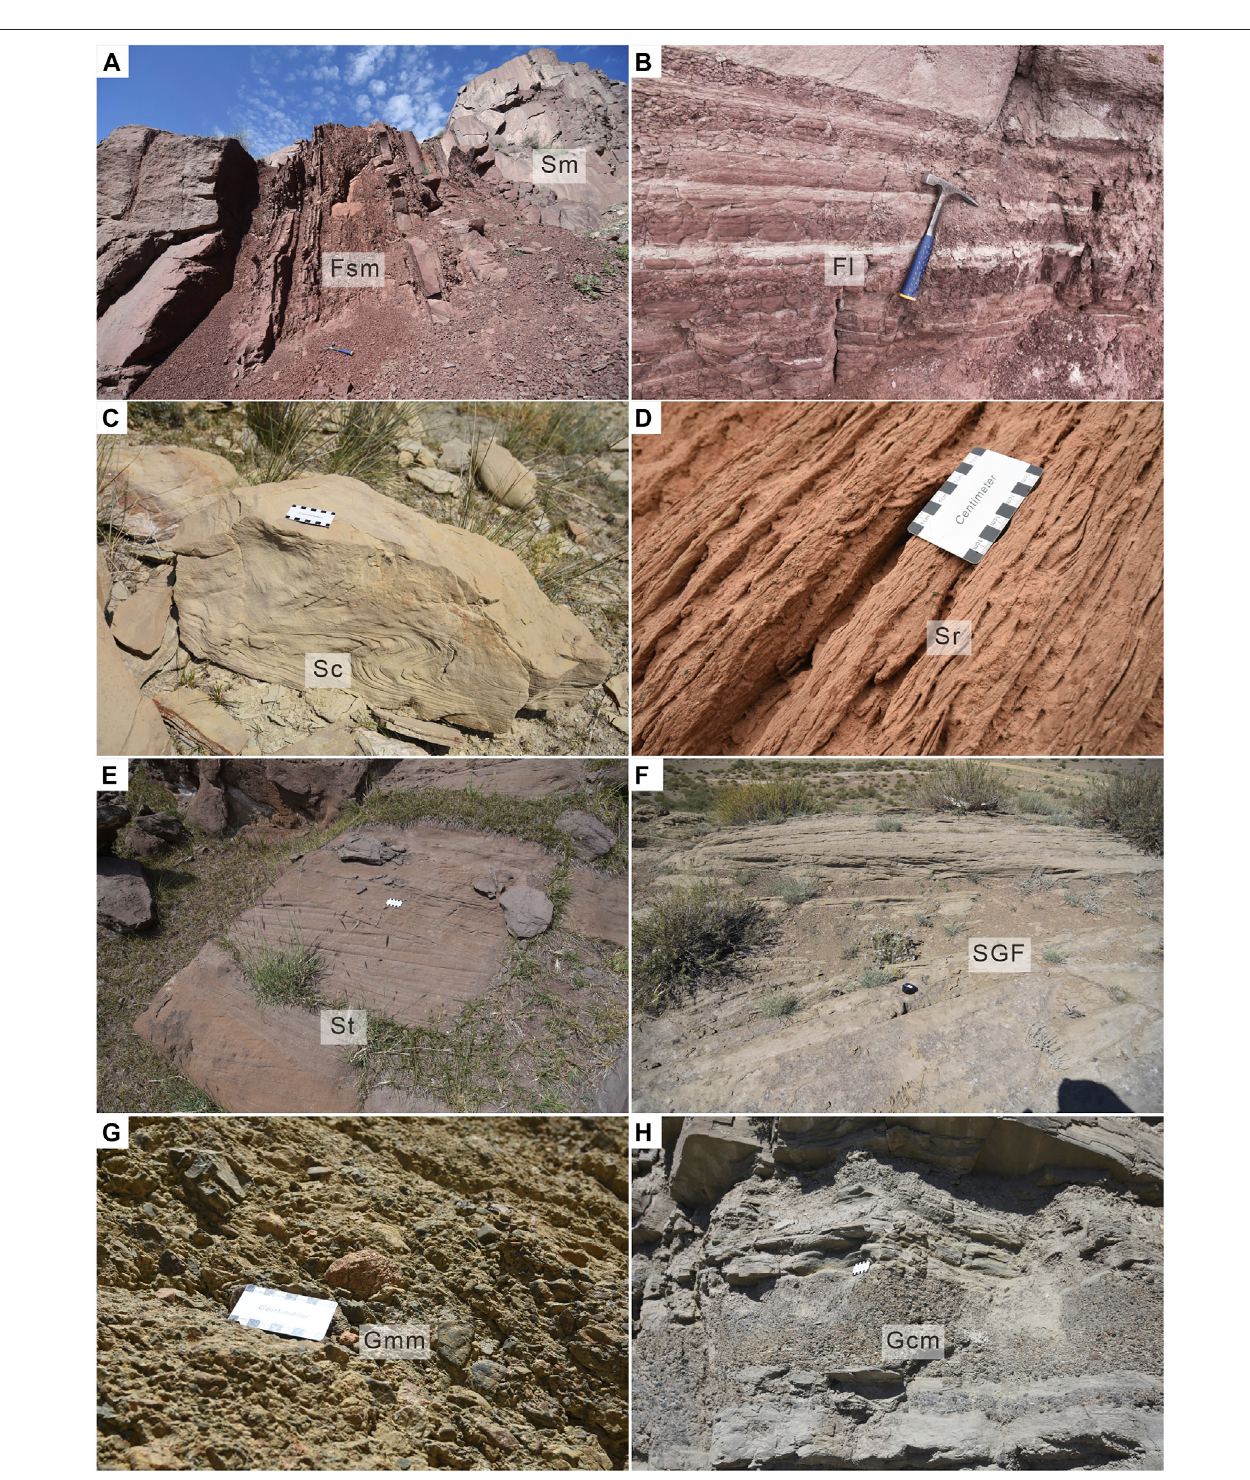
FIGURE 3 | Typical lithofacies in the late Mesozoic Southern Junggar Basin. (A) Fsm and Sm, Kalazha Formation, Wangjiagou section; (B) Fl, Qigu Formation, Jiangong mine section; (C) Quergou section; (D) Sikeshu River section; (E) St, Qigu Formation, Quergou section; (F) SGF, Kalazha Formation, Wangjiagou Formation; (G) Gmm, Kalazha Formation, Jiangong mine section; (H) Gcm, Qinghsuihe Formation, Jiangong mine section. The de fi nition of lithofacies see Table 1 .